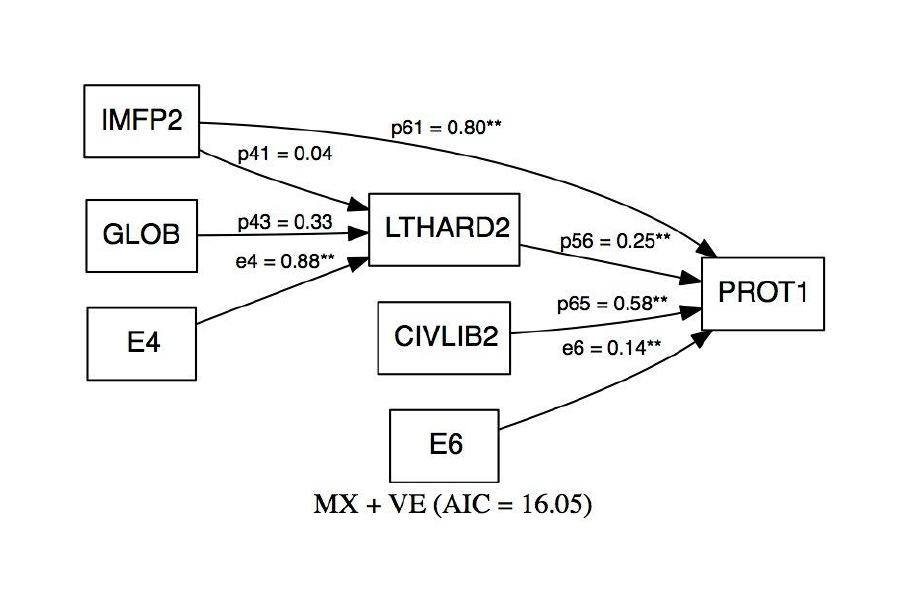
Figure 4. Argentina simplified FF Model (*p <= 0.05, **p <=